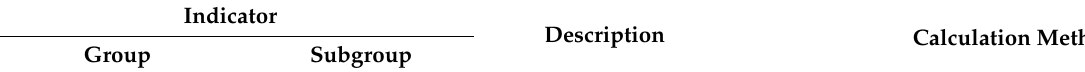
Table 1. Description of the selected indicators, Healthy People